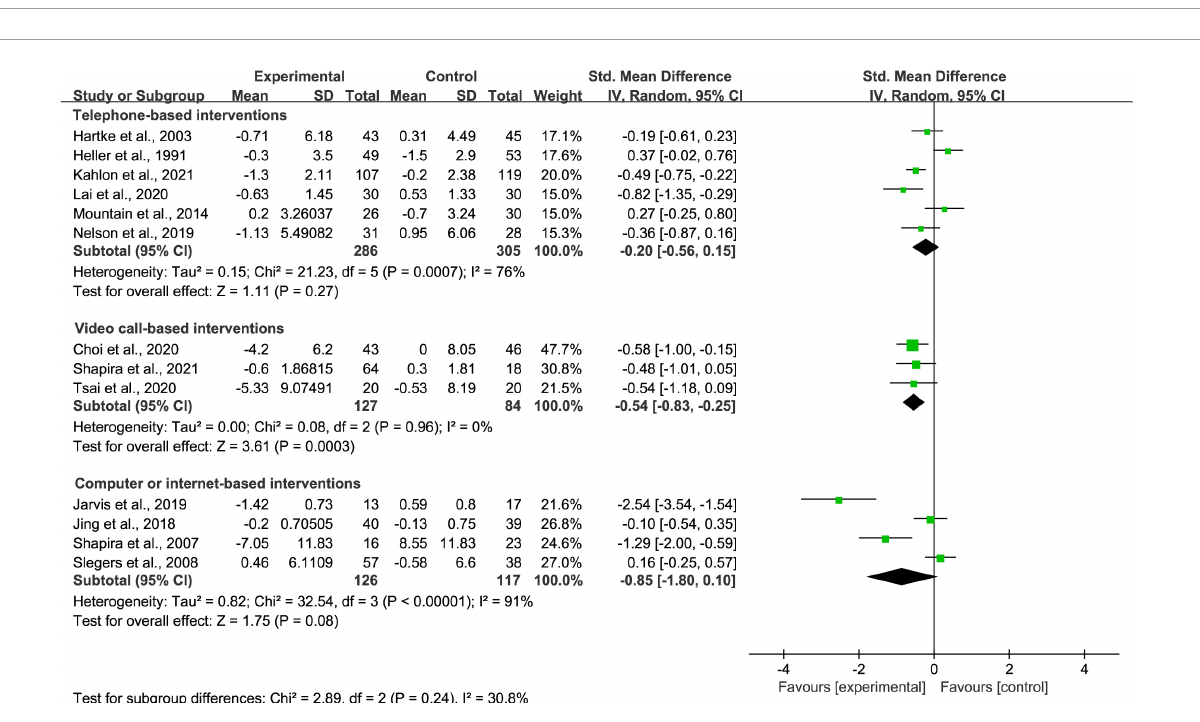
FIGURE4 Subgroup analysis: comparison of telephone-based interventions, video call-based intervention or computer or internet-based interventions and all controls on the basis of loneliness